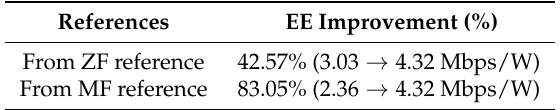
Figure 12. Performance of proposed BS with various parameter adjustments: ( a ) TP (bps); and ( b ) EE (bps/W). Table 5. Expected performance improvement using the proposed